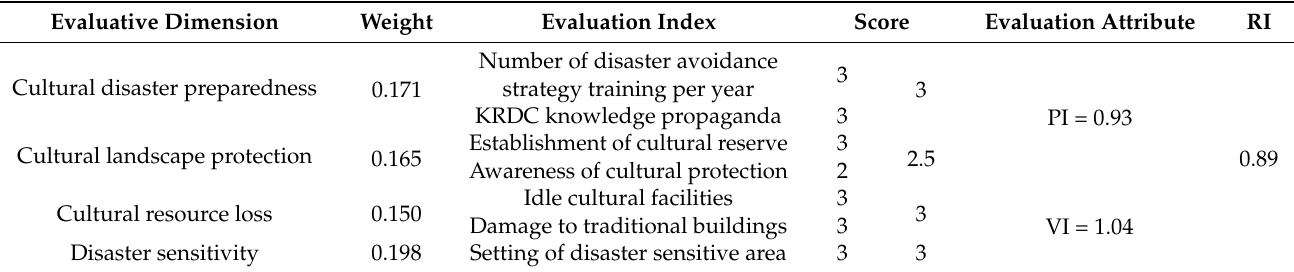
Table 5. Assessment results of sociocultural resilience in Fanhua village.